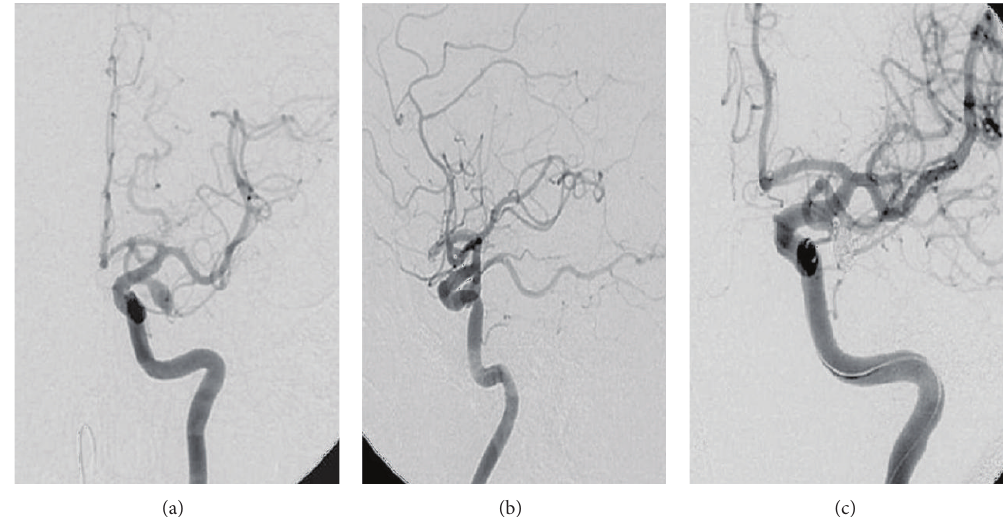
Figure 2: Left internal carotid DSA: AP (a) and lateral views, (b) demonstrating aneurysm of left PCoA, (c) AP view after embolisation (coils) showing complete obliteration of the